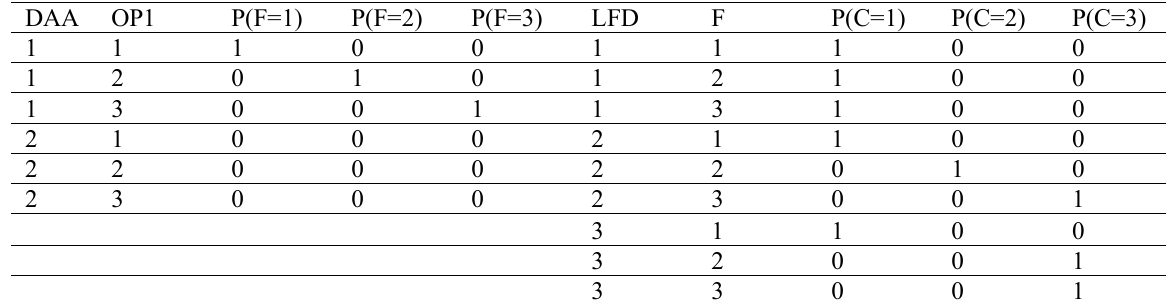
Table 11. States related to nodes C and